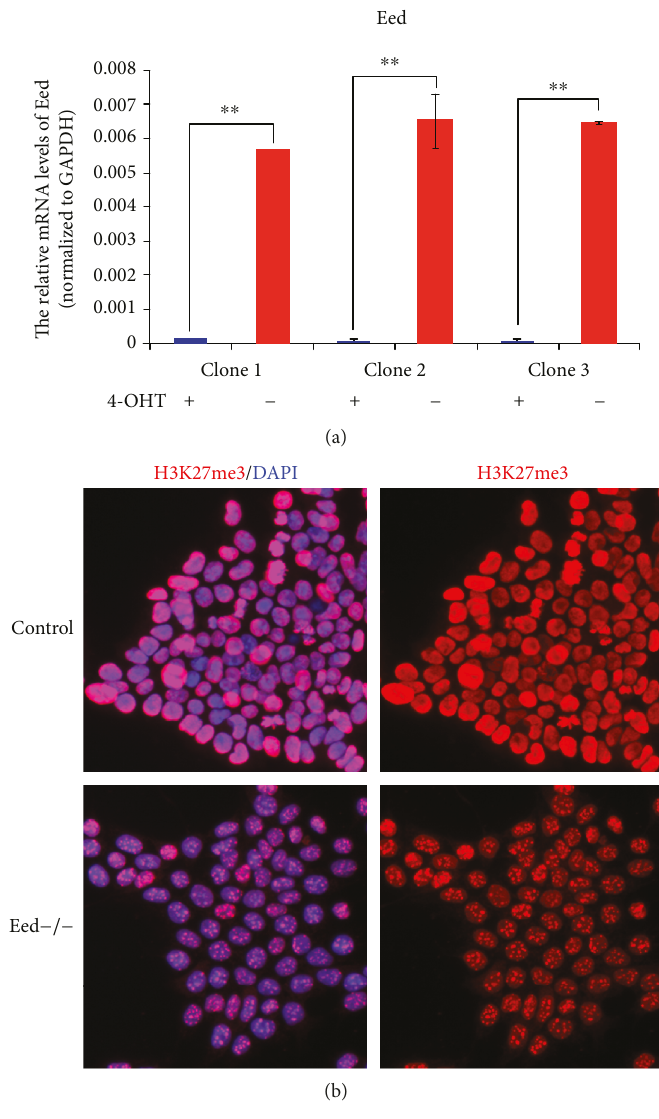
Figure 4: Validation of Eed knockout mESCs. (a) RT-qPCR results indicate that transcription was totally abrogated in Eed knockout clones generated by 4-OHT treatment. Relative quanti fi cation of mRNA levels was performed by the delta Ct (dCt) method and normalized to endogenous GAPDH. Means ± SD are shown. ∗∗ p < 0 01 . (b) Compared to controls, H3K27me3 expression (red, by H3K27) was dramatically decreased in Eed knockout mESCs generated by Cre-LoxP recombination upon 4-OHT treatment. Blue indicates DAPI